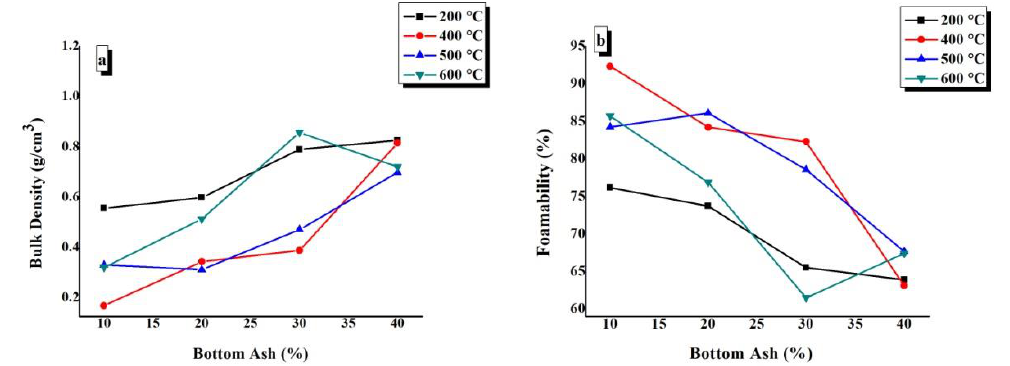
Figure 7. E ff ect of bottom ash content on ( a ) bulk density and ( b ) foamability of Figure 7. Effect of bottom ash content on ( a ) bulk density and ( b ) foamability of TGPFs.